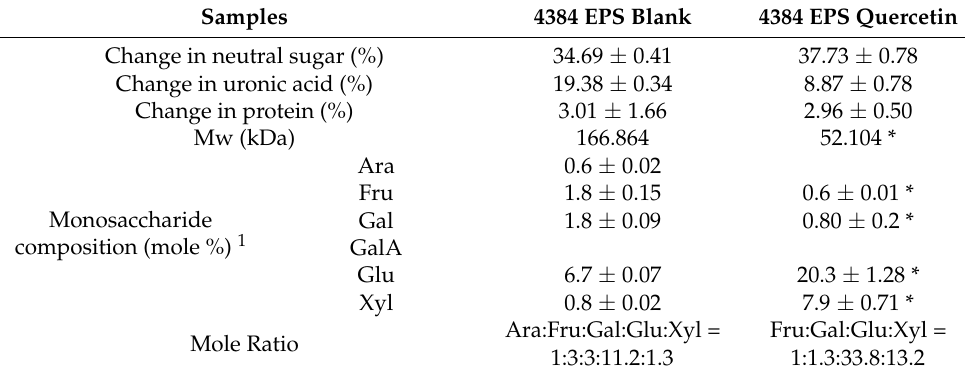
Table 2. Chemical composition of G-EMP.